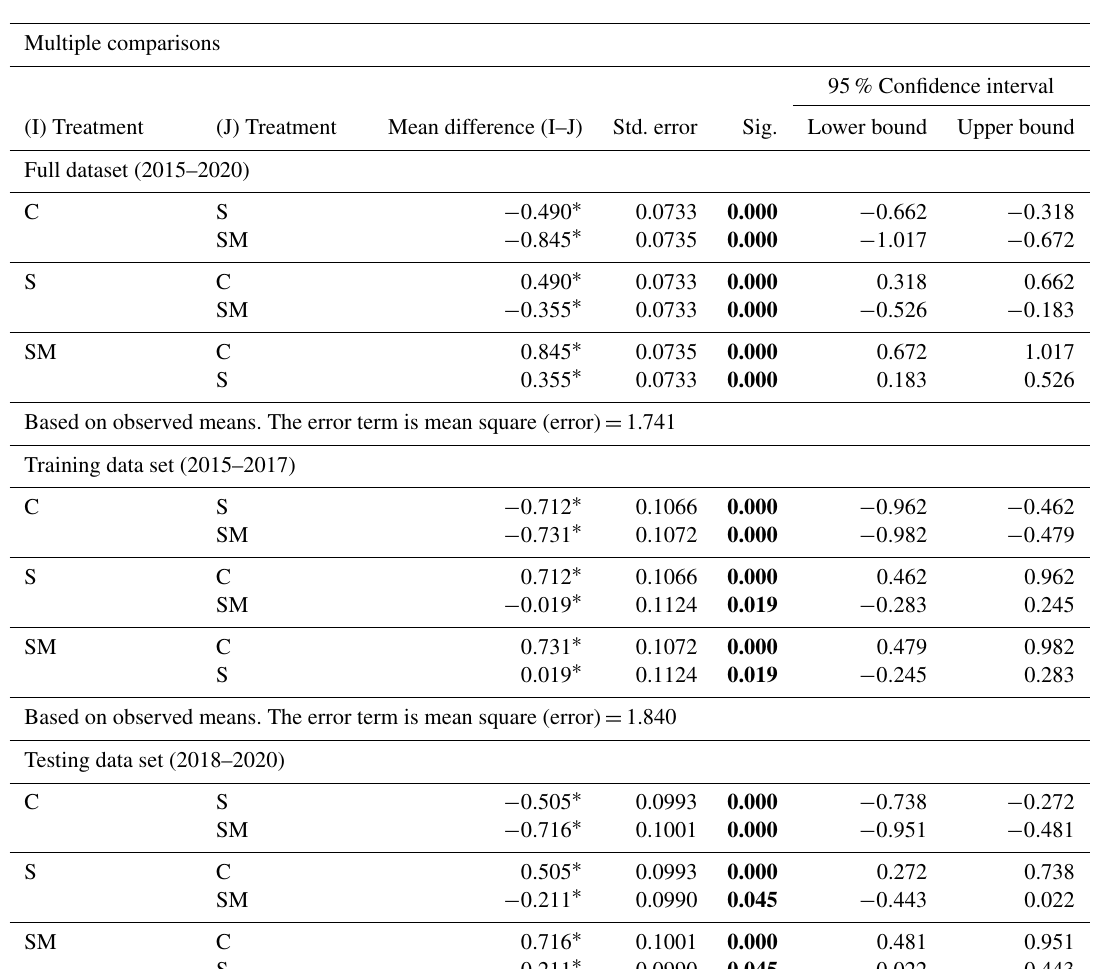
Table 1. The impact of sediment (S) and submerged aquatic macrophytes (SM) on evaporation rates ( E p ) of class A pan (C) in the full